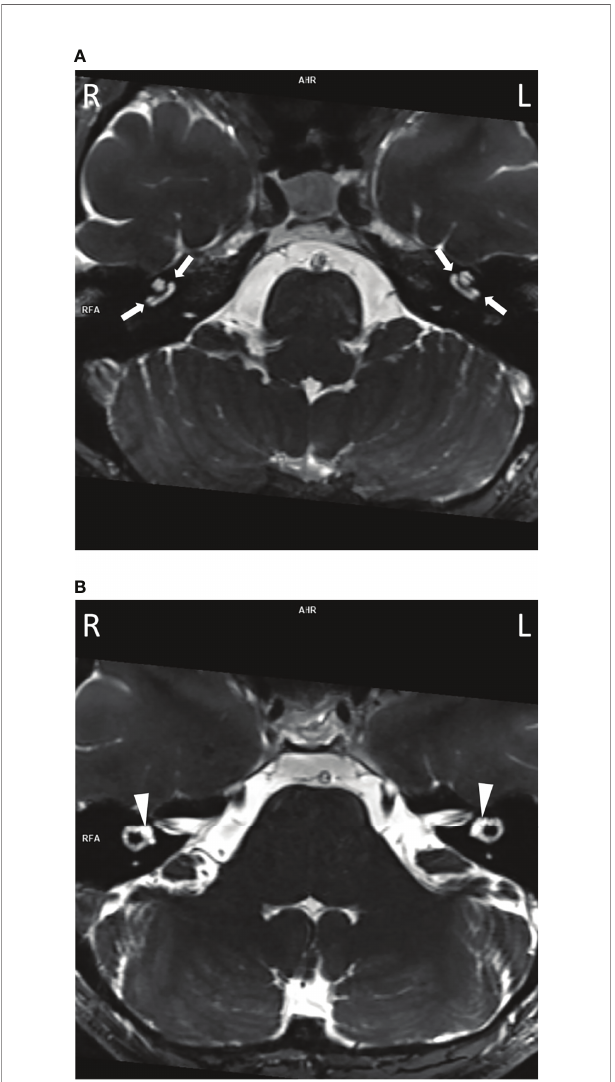
FIGURE 5 | The decreased bright cochlear fl uid signal on T2-weighted images in the proband. Slight diminishing of the bright fl uid signal was visible in both cochleas ( A , arrows) compared to vestibules ( B , arrowheads) and more pronounced on the